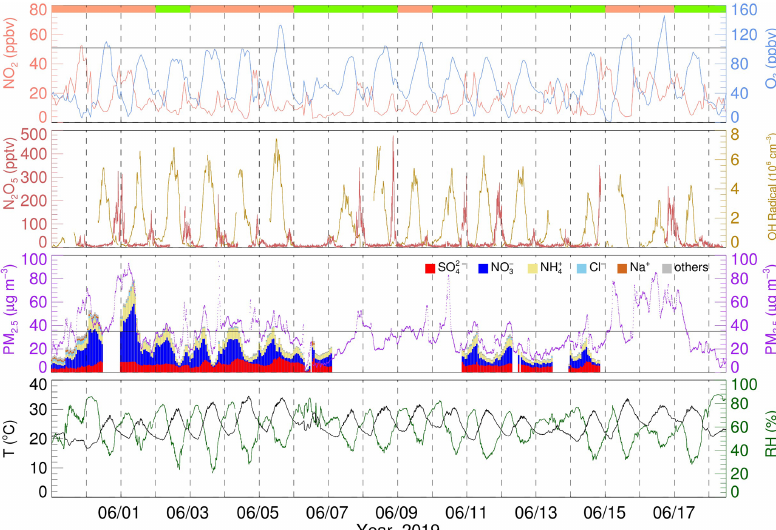
Figure 2. Time series of NO 2 , O 3 , N 2 O 5 , OH radicals, PM 2 . 5 , and water-soluble particulate components, temperature, and RH. The vertical dotted line represents the zero clock. The black horizontal solid line in the O 3 and PM 2 . 5 panels represents Chinese national air quality standards for O 3 and PM 2 . 5 , respectively. The top panel color blocks represent the PM 2 . 5 clean day (light green) and PM 2 . 5 polluted day (salmon).